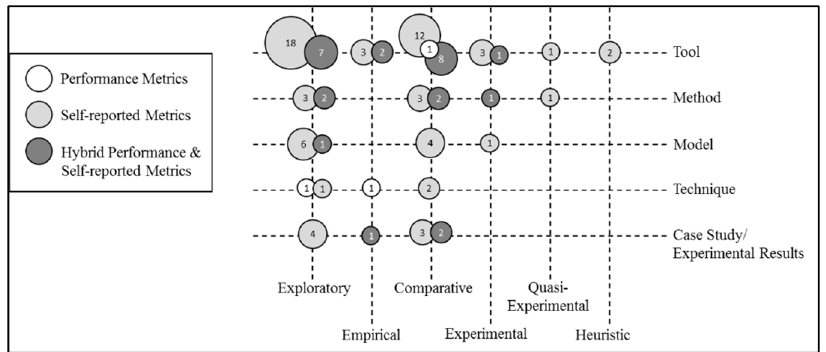
Figure 15. Three-dimensional mapping of research types, metrics, and contribution types.